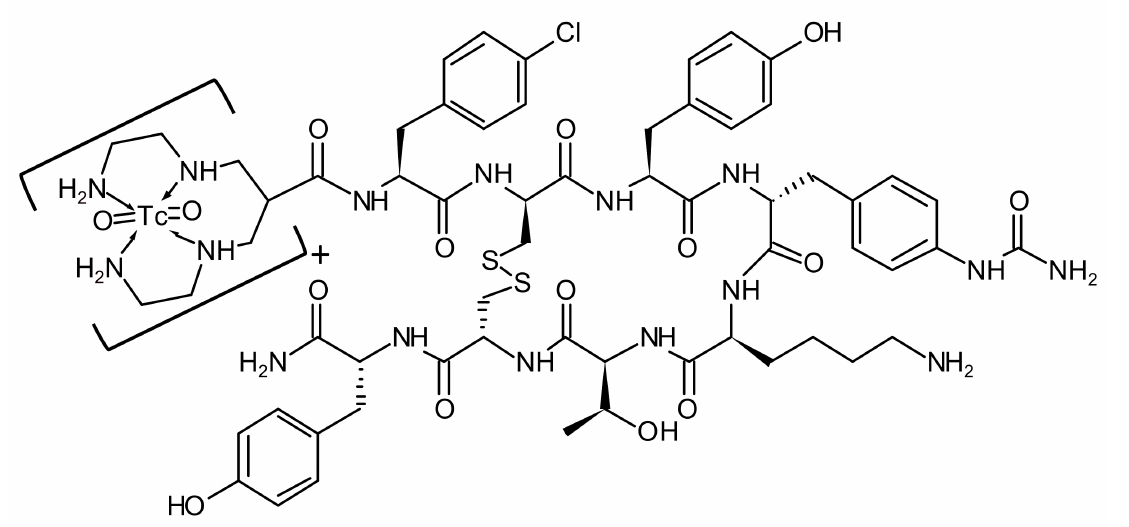
Figure 1. The chemical structure of [ 99m